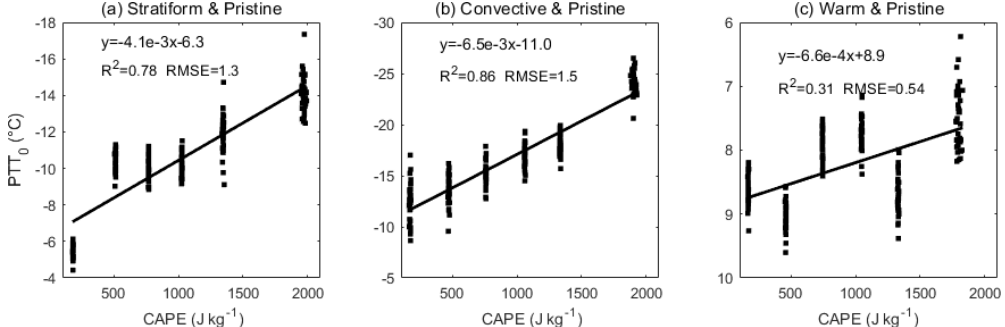
Figure 10. The variation in the PTT 0 with CAPE under pristine conditions for (a) deep stratiform precipitation, (b) deep convective precip- itation, and (c) warm precipitation. The results are derived from a randomly selected 70% of the pristine precipitation